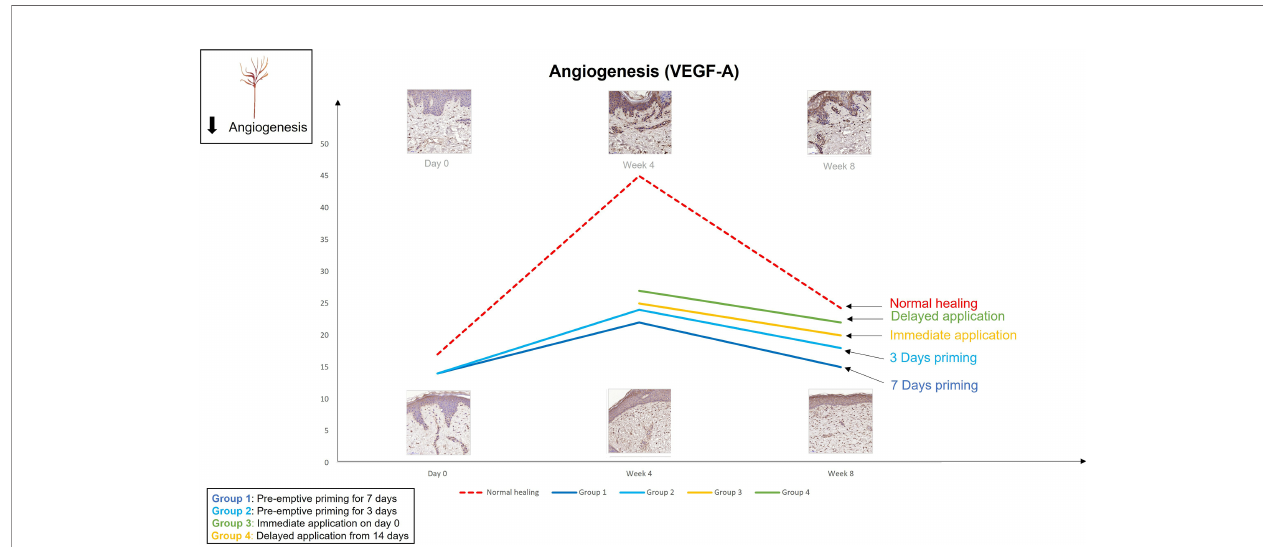
FIGURE 4 | We evaluated the pre-emptive, immediate and delayed intervention of topical Epigallocatechin-3-gallate on skin scarring by conducting a randomsied double blind controlled trial on 40 healthy volunteers over 8 weeks. Graphical representation of the trends for angiogenesis (VEGFA) which demonstrates that pre- emptively priming the skin 7 days prior to injury shows greater reductions in VEGFA compared to all other modes of